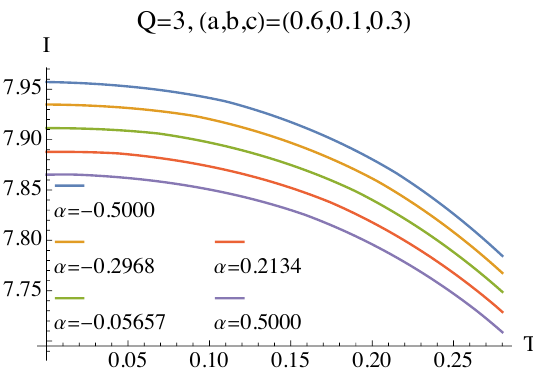
Figure 7 . The MI vs T in different value of T . It shows the change rule between the MI and two parameters T and α that the MI decreases with the increase of T and α